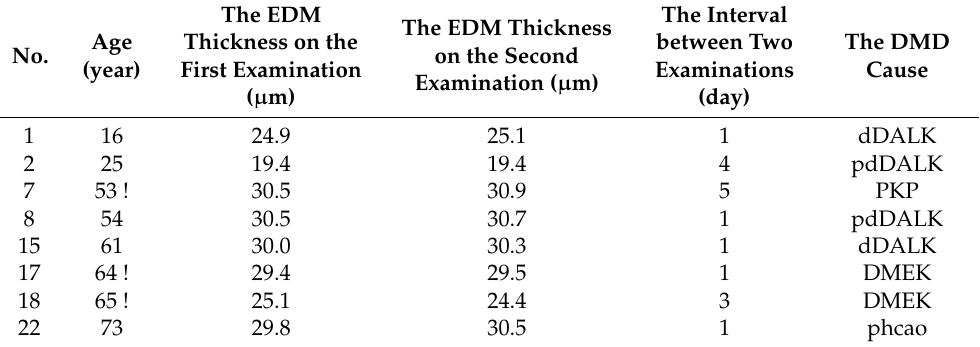
Table 2. Data of 8 subjects who had two HD-OCT examinations before DM reattachment.